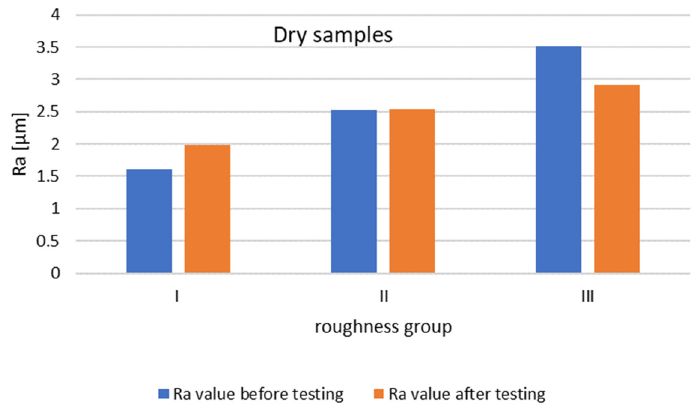
Figure 14. Change in Ra value of the pin surface after 30 min of dry running.